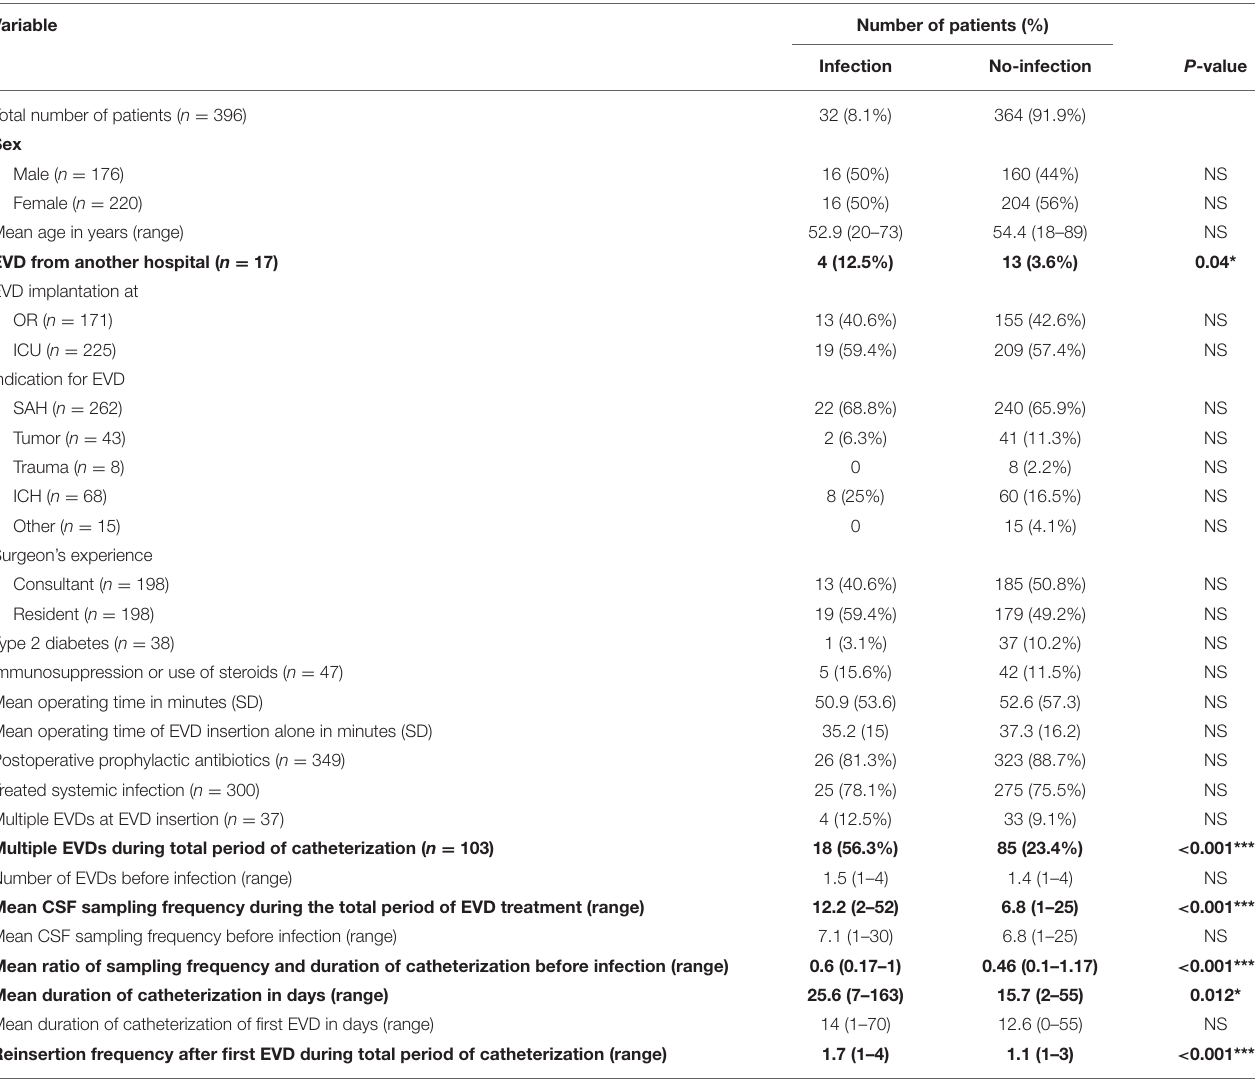
TABLE 3 | Differences in patient characteristics and EVD management between patients with and without EVD associated infections.